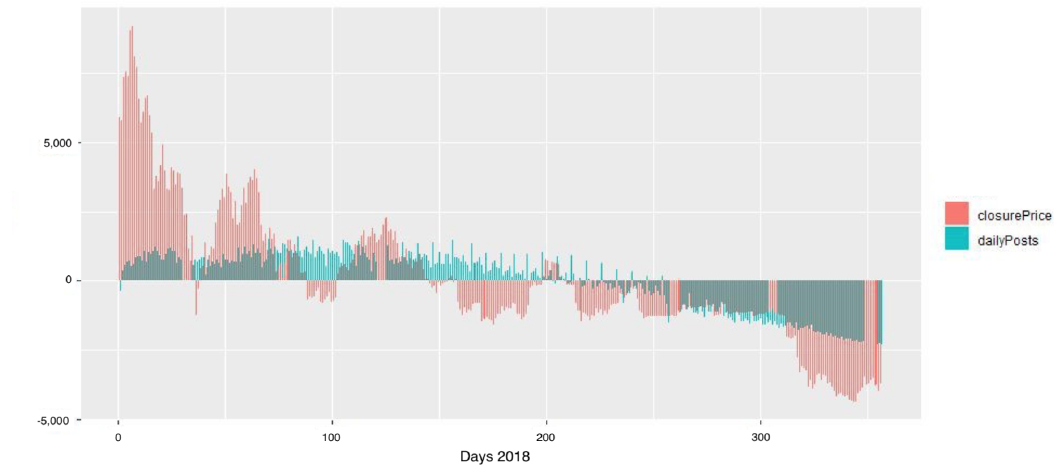
Figure 10. Comparison between the variation of posts per day and the daily closing value in